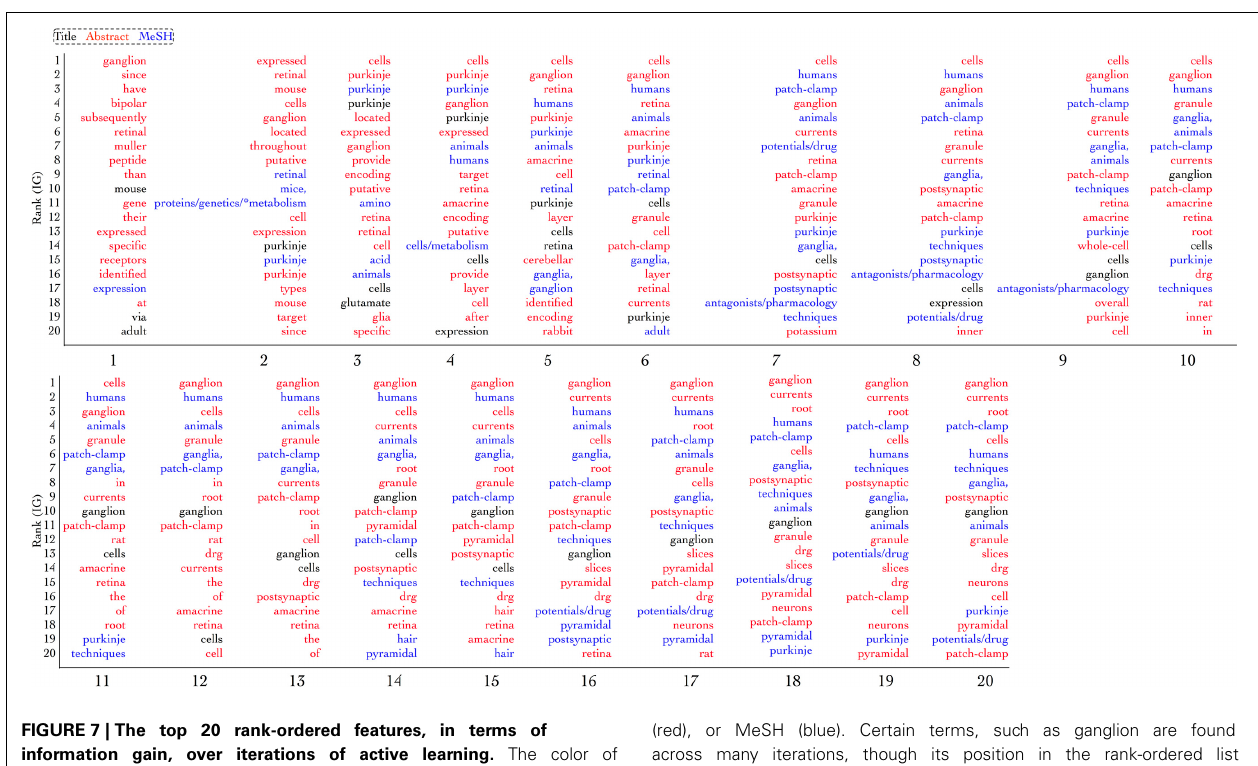
(red), or MeSH (blue). Certain terms, such as ganglion are found across many iterations, though its position in the rank-ordered list changes, while others, such as “via” were less informative, appearing only in the first